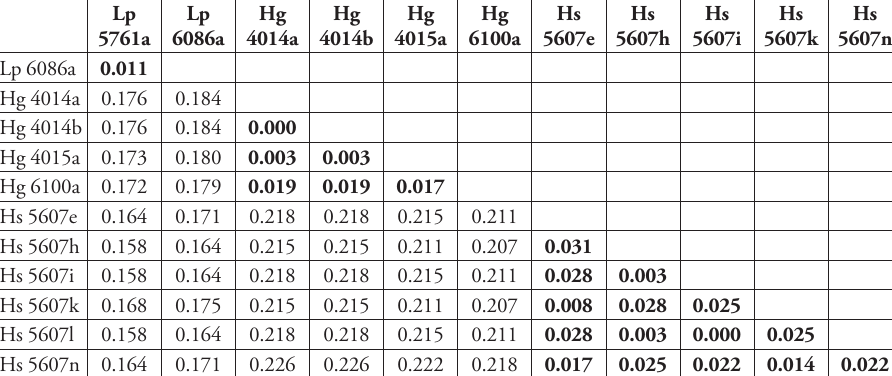
Table 2. Kimura-2-Parameter (K2P) genetic distances for COI barcodes between Ephemeroptera speci- mens; specimens represented by voucher numbers (see Table 2). Intraspecific distances represented in bold. Lp, Leentvaaria palpalis ; Hg, Hydrosmilodon gilliesae ; and Hs, Hydromastodon sallesi